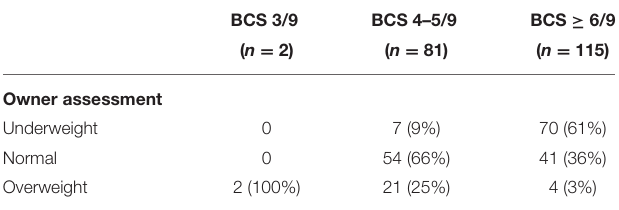
TABLE 5 | Comparison of body condition score and owner assessment of body